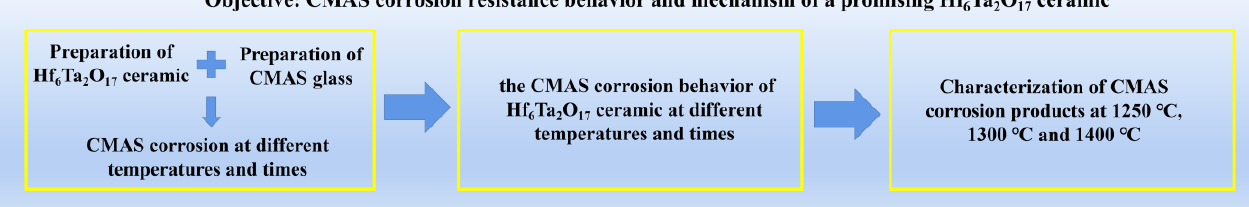
Figure 1. Schematic flowchart showing research